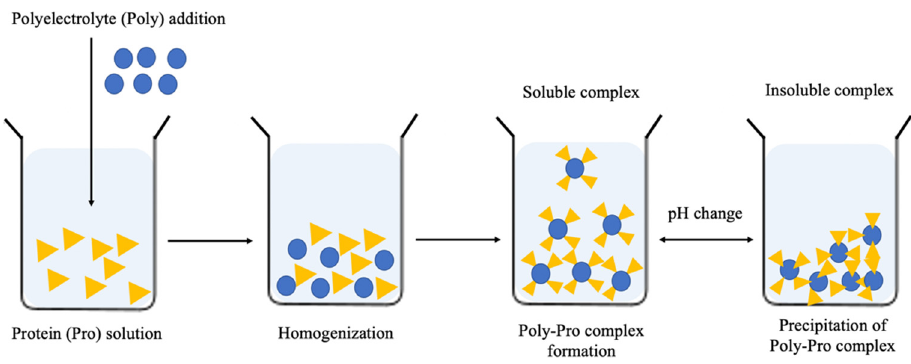
Figure 3. Schematic representation of polyelectrolyte-protein complex formation according to Campos et al. [10].